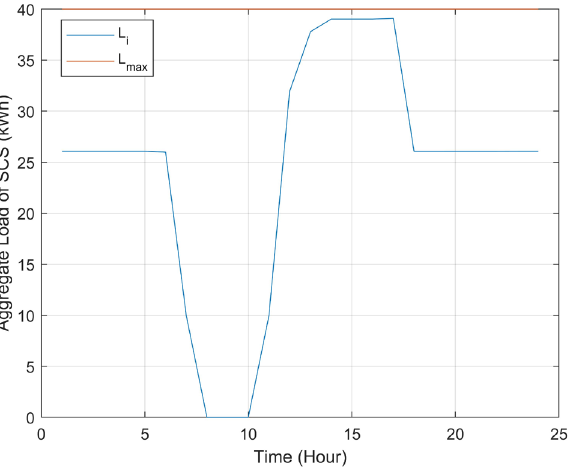
Figure 3. Charging of all PEVs at each moment acquired by AD-GEED.